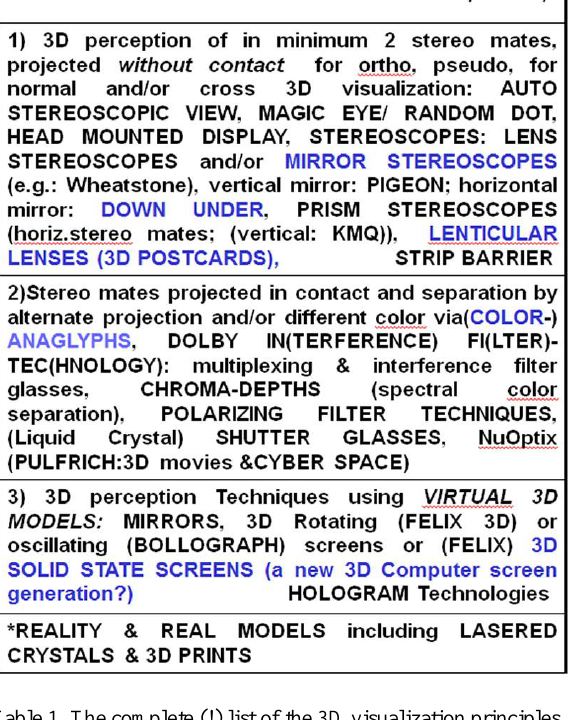
Table 1. The complete (!) list of the 3D visualization principles